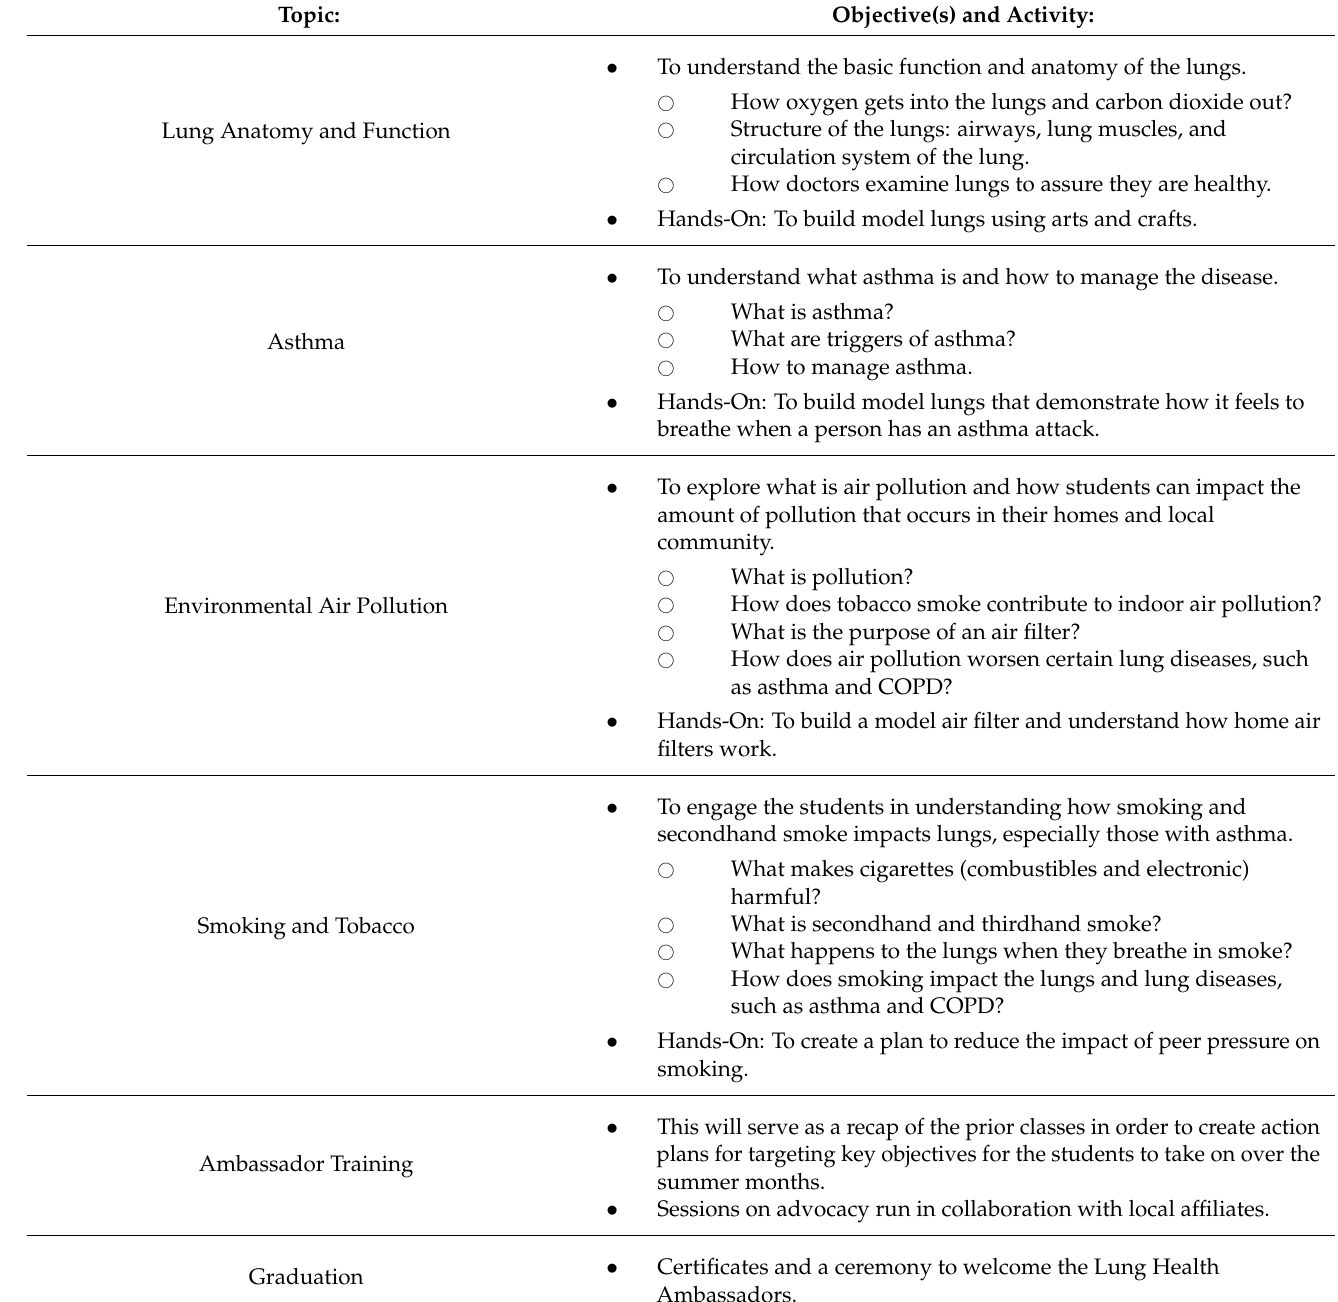
Table 1. Summary of the Lung Health Ambassador Program courses, objectives, and hands-on